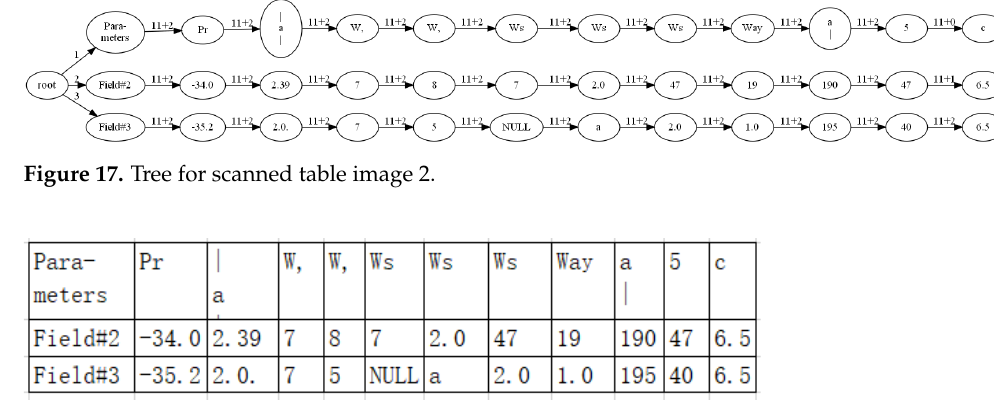
Figure 18. Excel output for scanned table image 2 by our algorithm.